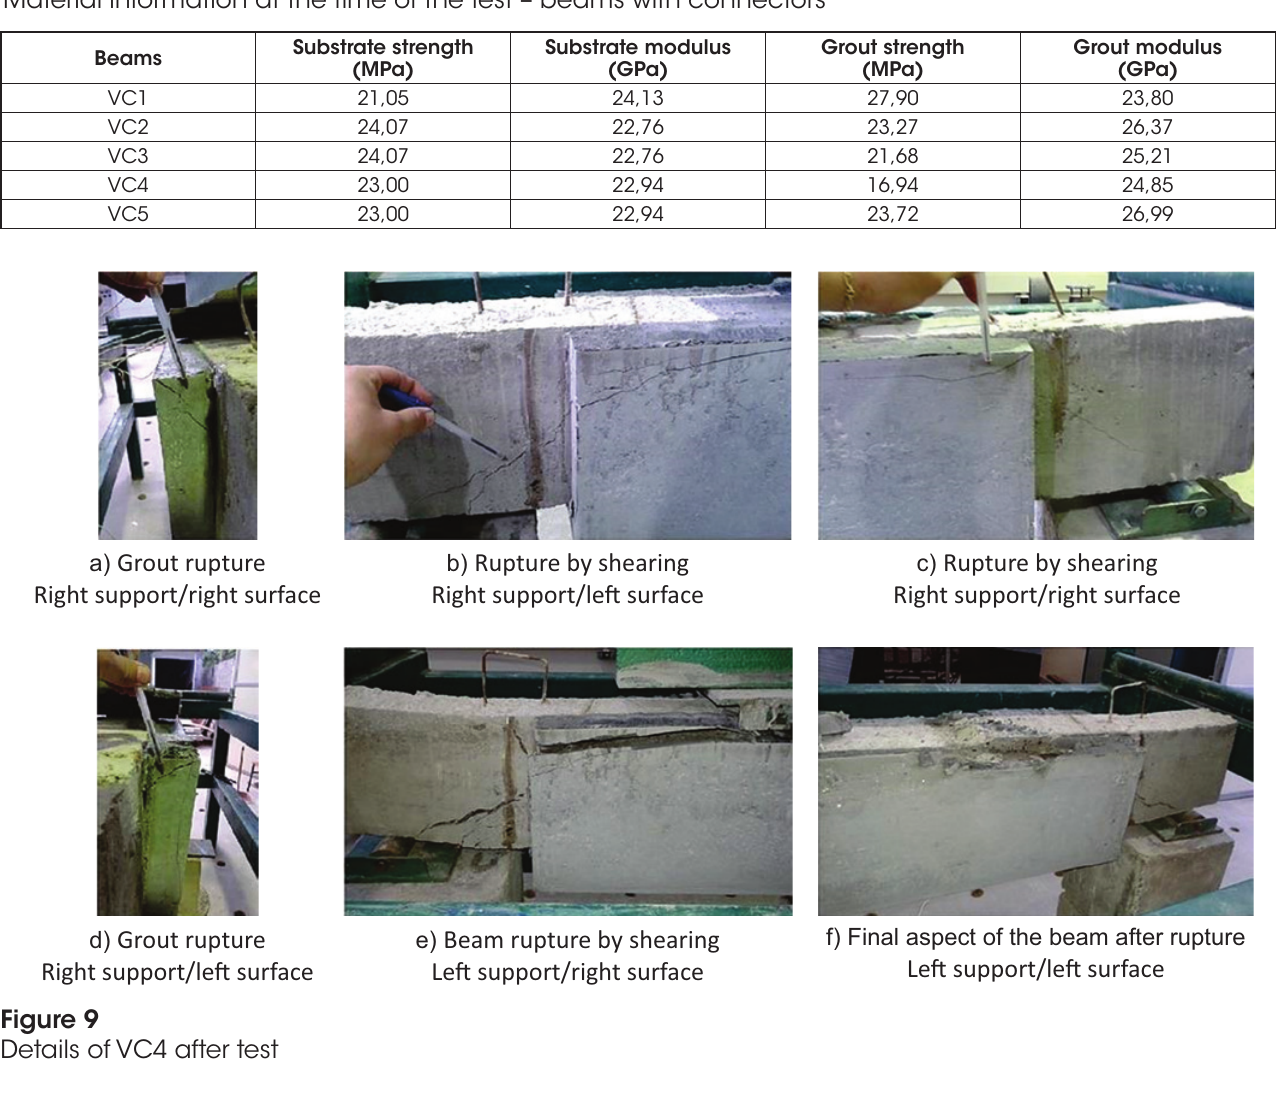
Material information at the time of the test – beams with connectors Beams